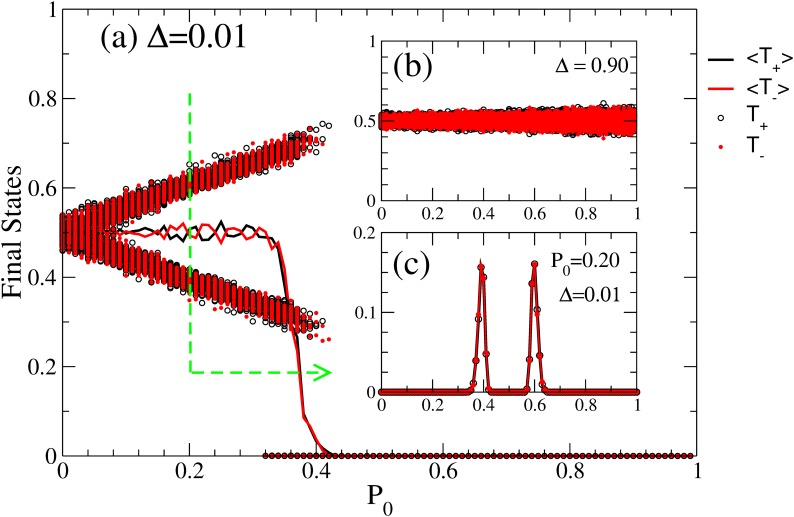
Analysis of Bi-polarization Region T
bp.Main Panel (a): Distribution of positive (T
+, black circles) and negative opinions (T
−, red circles) and their averages ( 〈T
+〉, 〈T
−〉 black and red thick lines respectively) as a function of P
0 for Δ = 0.01. The two branches in the bi-polarization regions mean the presence of dominant and dominated opinions for this value of Δ. Insets: Panel (b): Same quantities for Δ = 0.9. For large values of Δ, there does not exist a dominant opinion. Panel (c): Bimodal distribution of positive and negative final opinions for P
0 = 0.20 and Δ = 0.01.